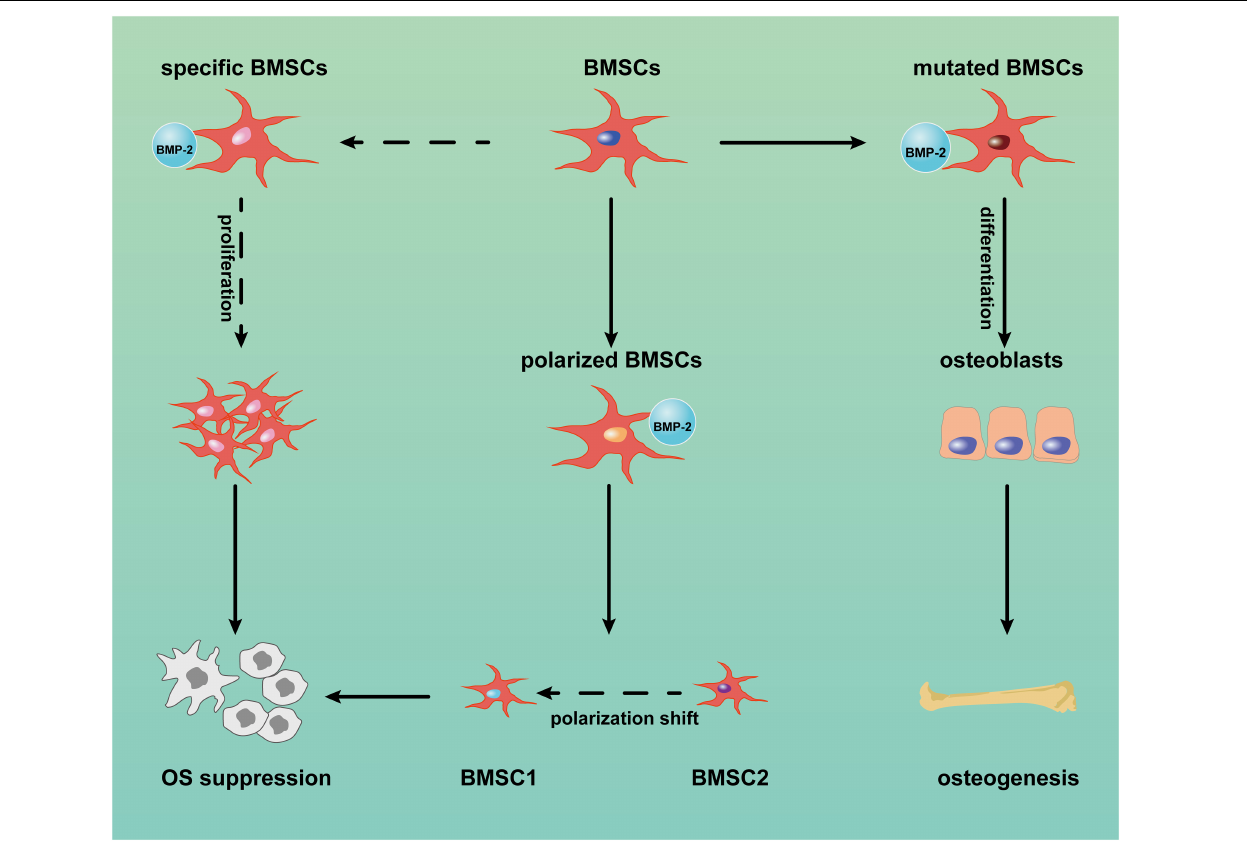
FIGURE 2 | Potential mechanism of bone morphogenic protein-2 (BMP-2) induced tumor suppression via bone marrow-derived mesenchymal stem cells (BMSCs). BMP-2 may induce mutated BMSC differentiation into normal osteoblasts. Conversely, BMP-2 may promote the proliferation of specific BMSCs with anticancer capacity and the shift of BMSC polarization from MSC2 (tumor promotion) to MSC1 (tumor inhibition). OS: osteosarcoma.